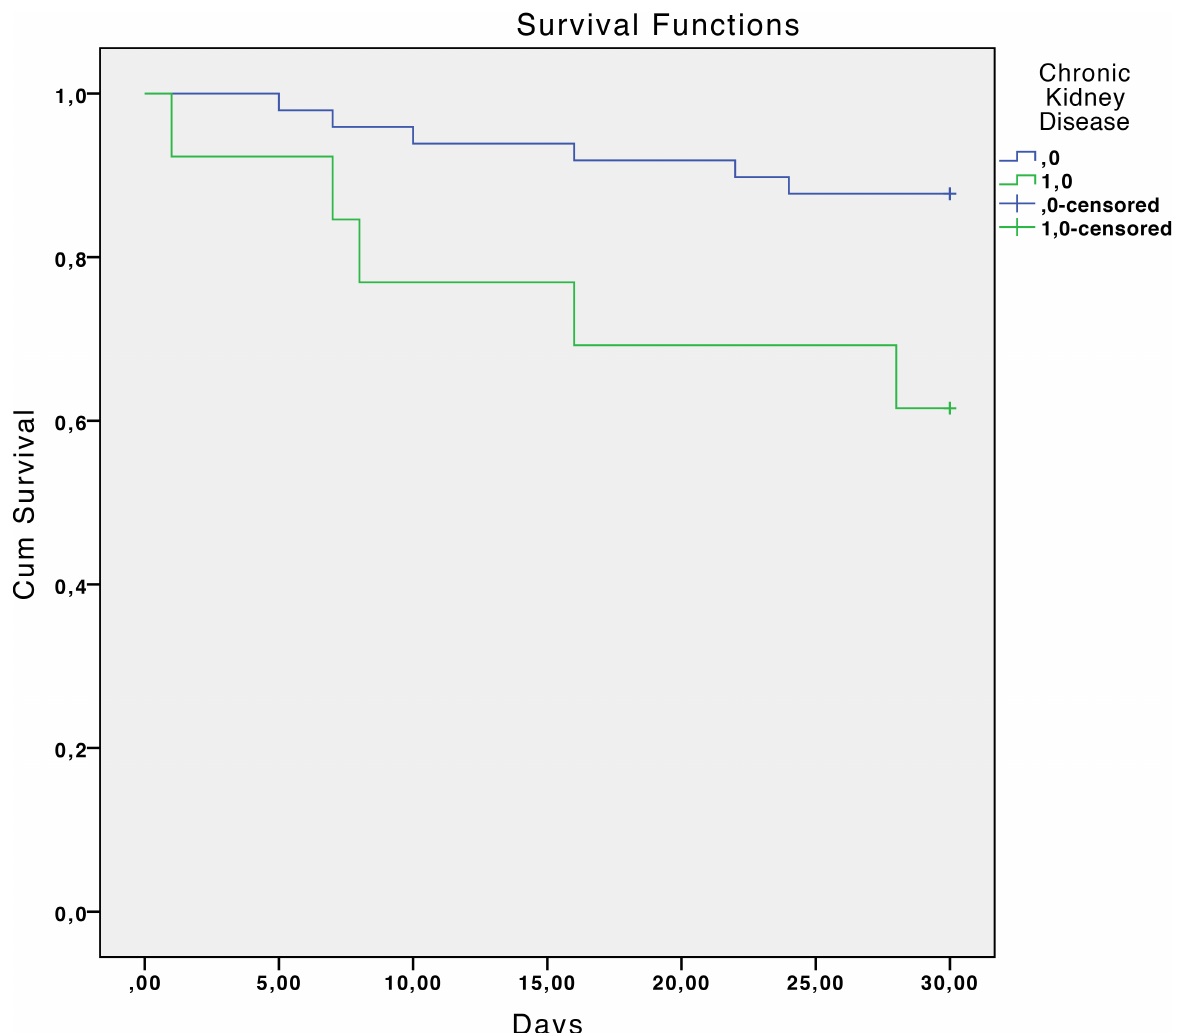
Fig 3. Kaplan-Meier 30-day survival curve according to chronic renal failure. P = 0.02 (log-ranktest).